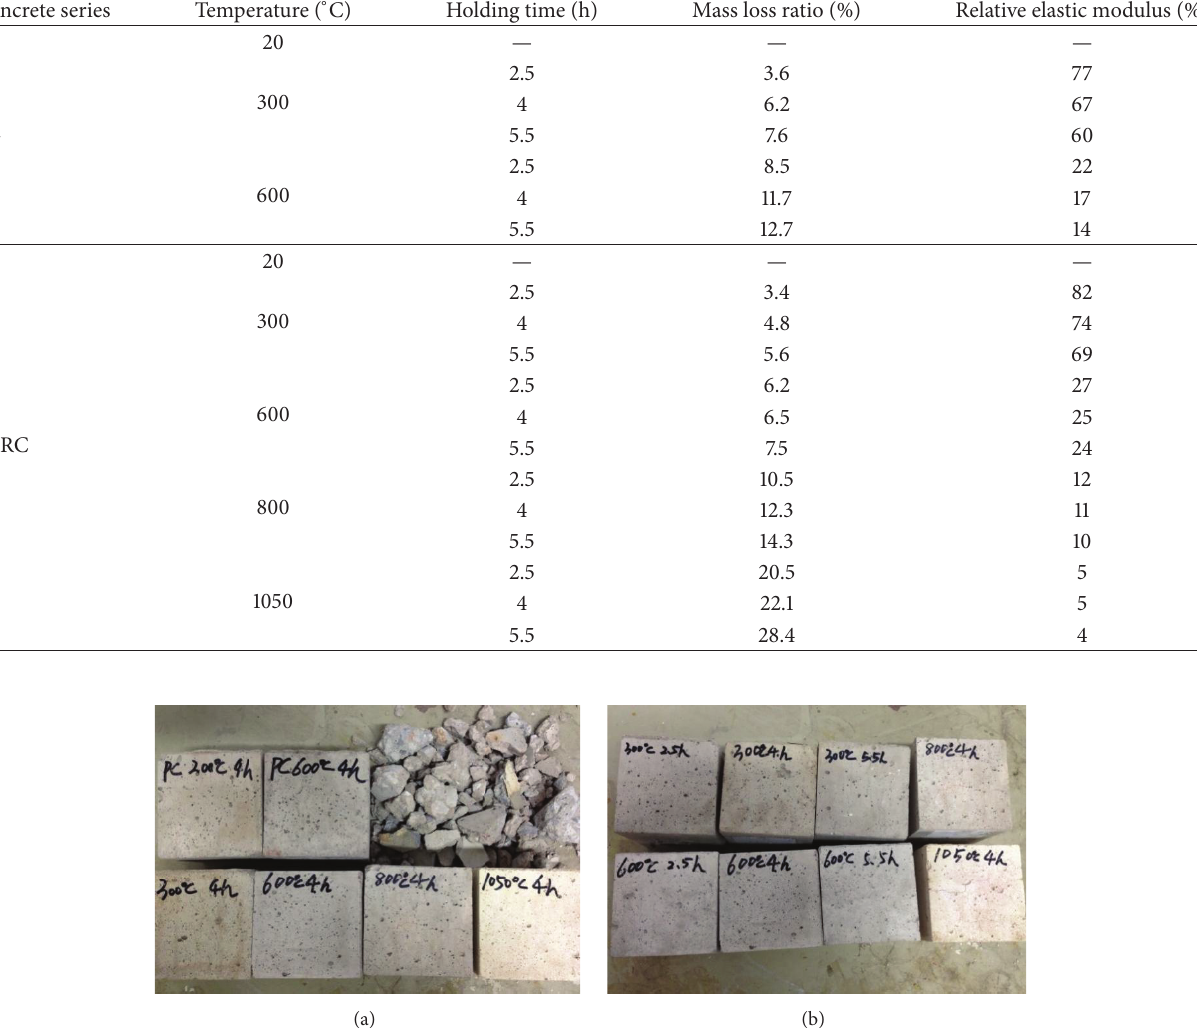
spalling. The relative elastic modulus, detected by a non- destructive ultrasonic detector, is an effective parameter for characterizing the degree of damage of concrete exposed to different